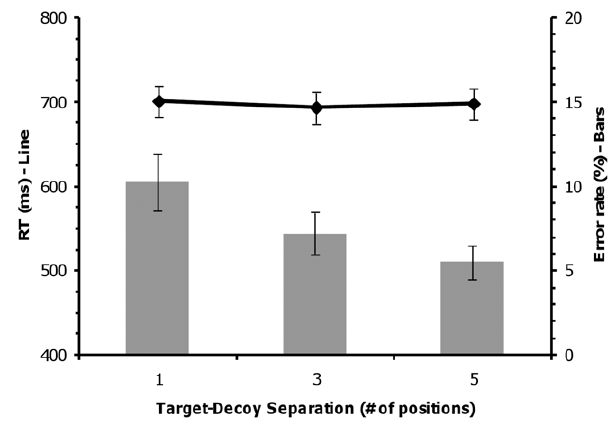
Figure 2. Behavioral results for Experiment 1. Mean reaction time (line) and error rates (bars) as a function of target-target separation for the same/different task in Experiment 1. Error bars are standard error. Note that participants committed more errors as the targets get closer together.